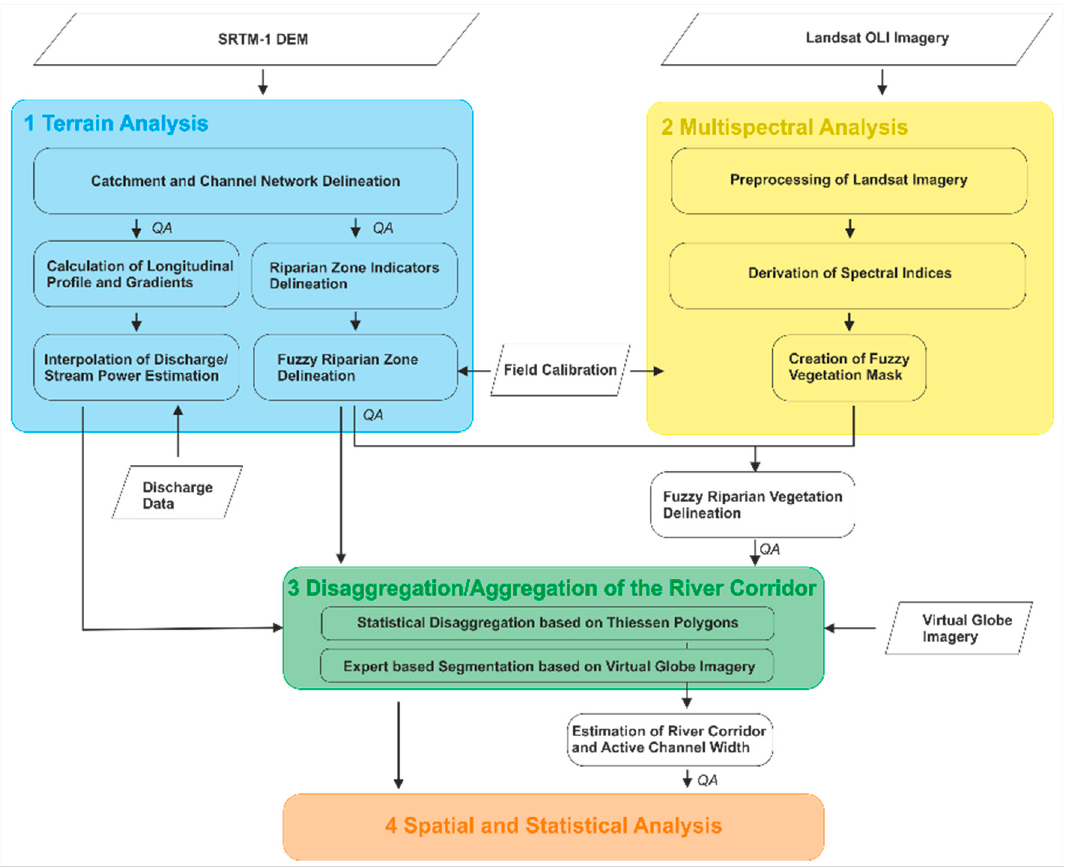
Figure 2. Workflow for riverscape analysis; QA stands for quality analysis.